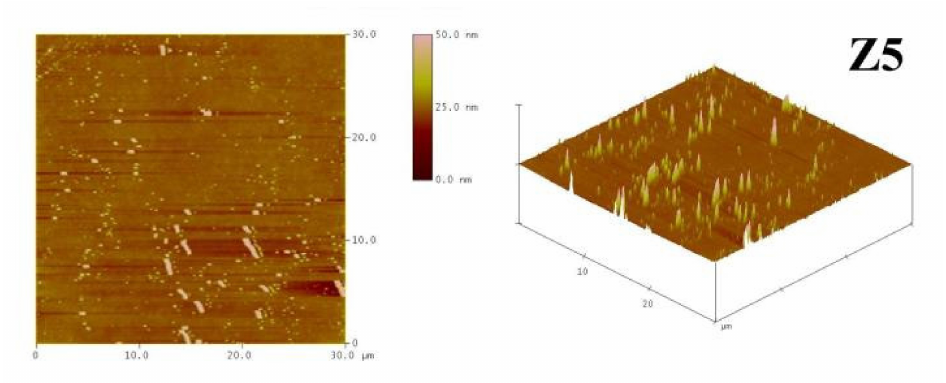
Figure 6. AFM diagram of Z3, Z5 composite coating.